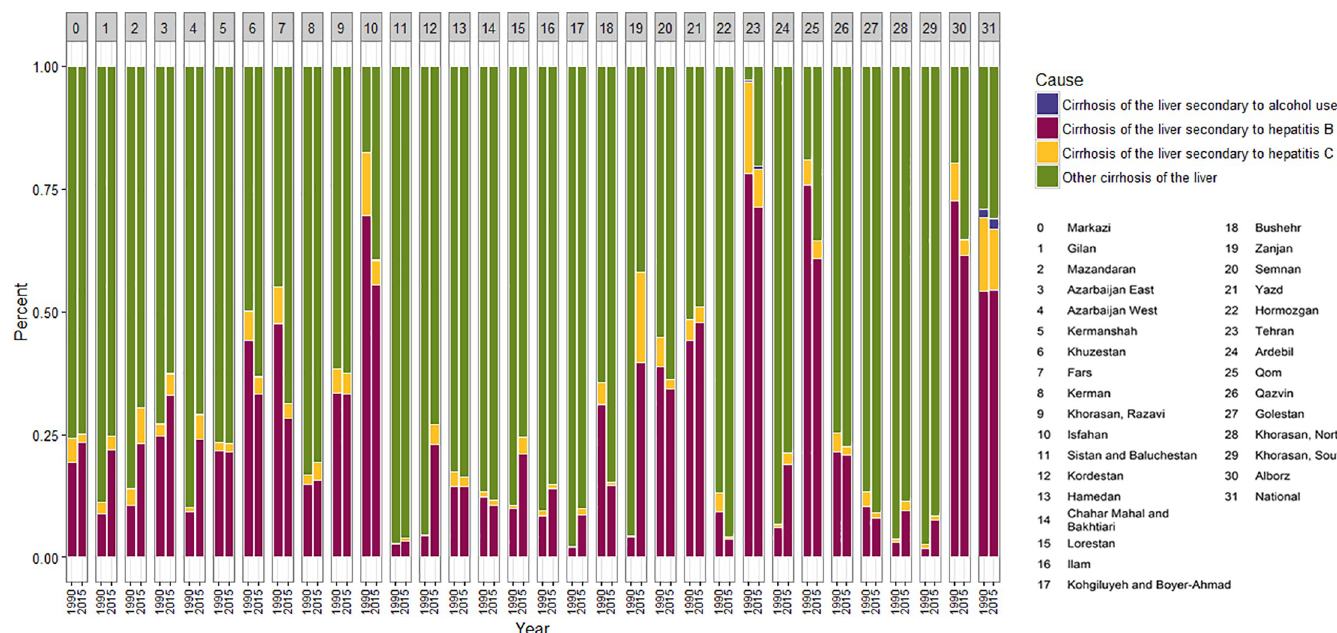
Fig 6. Cause specific liver cirrhosis mortality, age adjusted rate by province in Iran between 1990 and 2010.